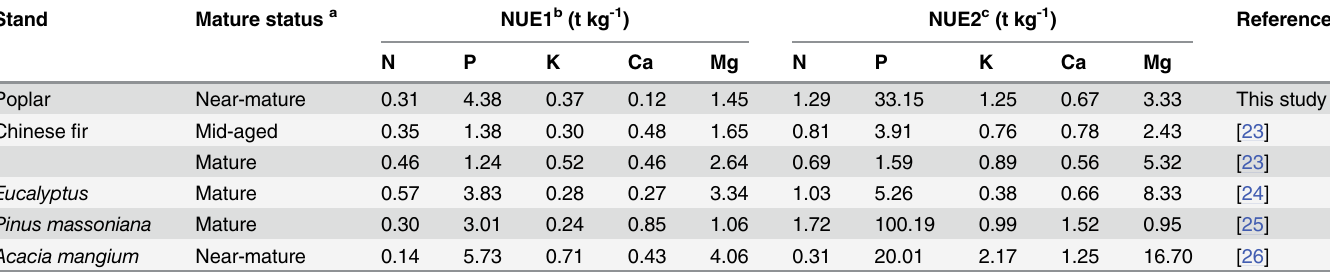
Table 5. Nutrient use efficiency of poplar and several plantation tree species in southern China. Stand